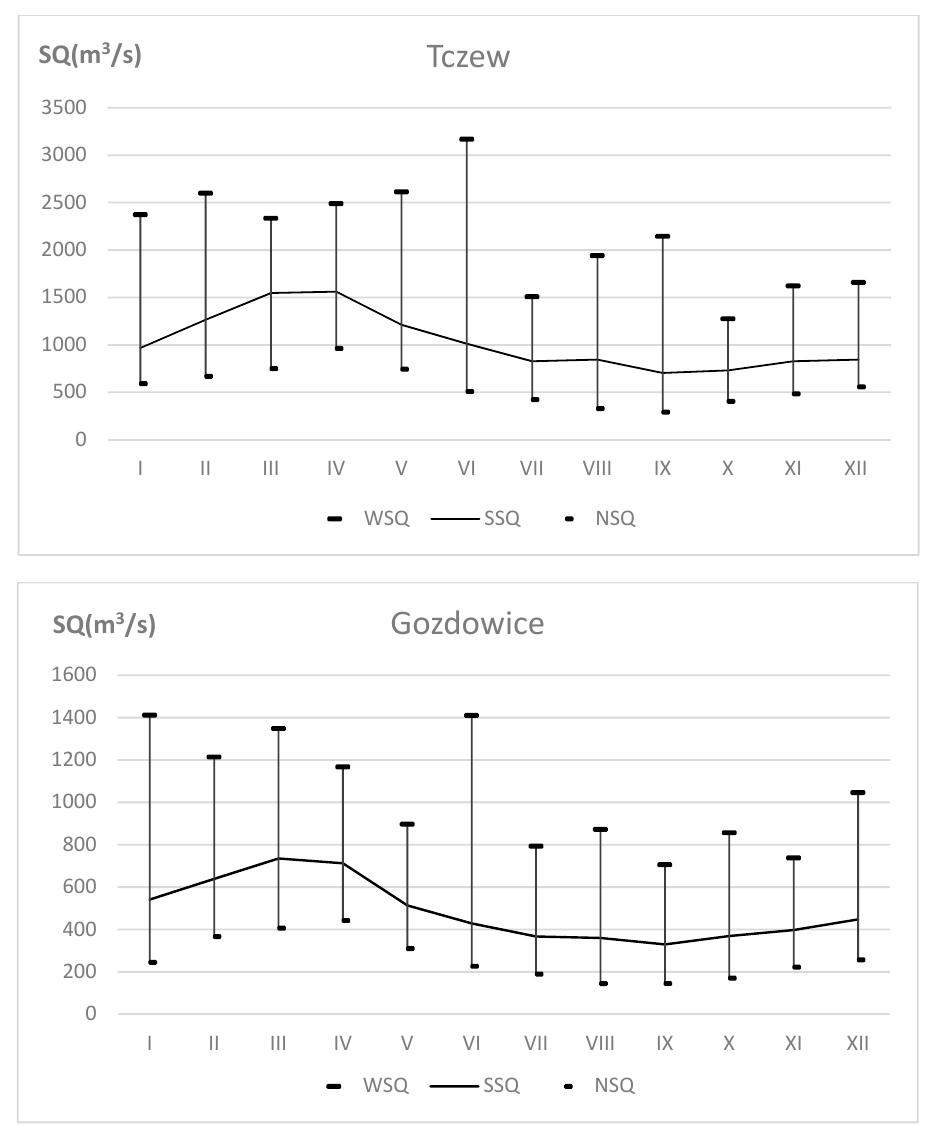
Figure 4. Average annual flows (SQ) of the Vistula in Tczew and the Oder in Gozdowice in the period 1999–2018 (based on Institute of Meteorology and Water Management—National Research Institute data).